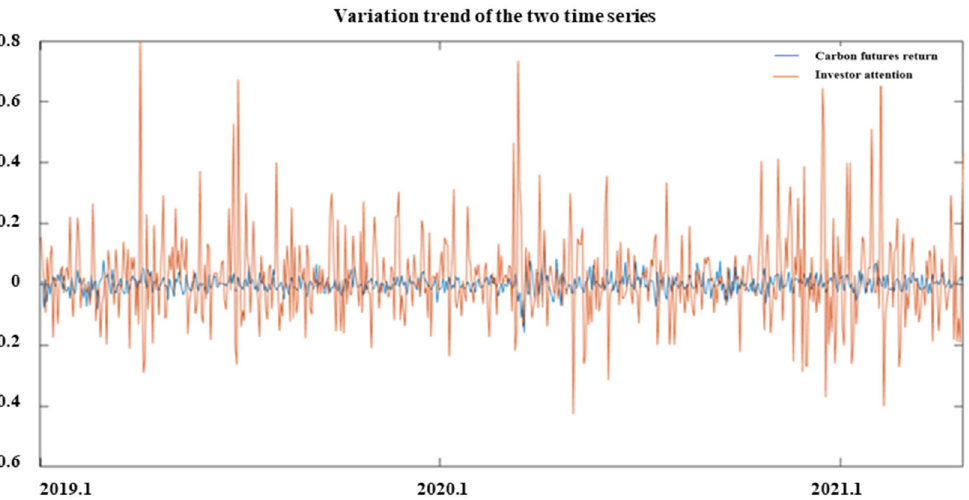
Figure 3. Variation trend of the two selected time series. The X-axis refers to the time while the Y-axis represents the values of return for the reported time series.